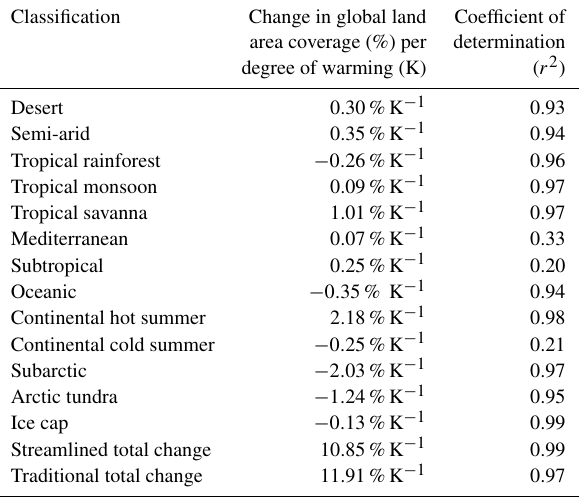
Table 4. Percentage change in the global land area of each of the streamlined classifications per degree of global warming. Change is based on linear approximations of results from reference period to 4K of